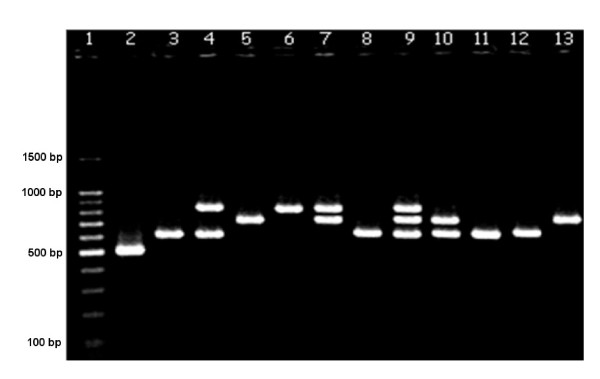
Electrophoresis of representative samples with each of the CagA EPIYA types seen in patients with H. pylori-associated diseases. Column 1: 100 bp standard; Column 2: EPIYA-AB; Columns 3, 8, 11, and 12: EPIYA-ABC; Column 4: EPIYA-ABC + -ABCCC; Columns 5 and 13: EPIYA-ABCC; Column 6: EPIYA ABCCC; Column 7: EPIYA-ABCC + -ABCCC; Column 9: EPIYA-ABC + -ABCC + -ABCCC; Column 10: EPIYA-ABC + -ABCC.